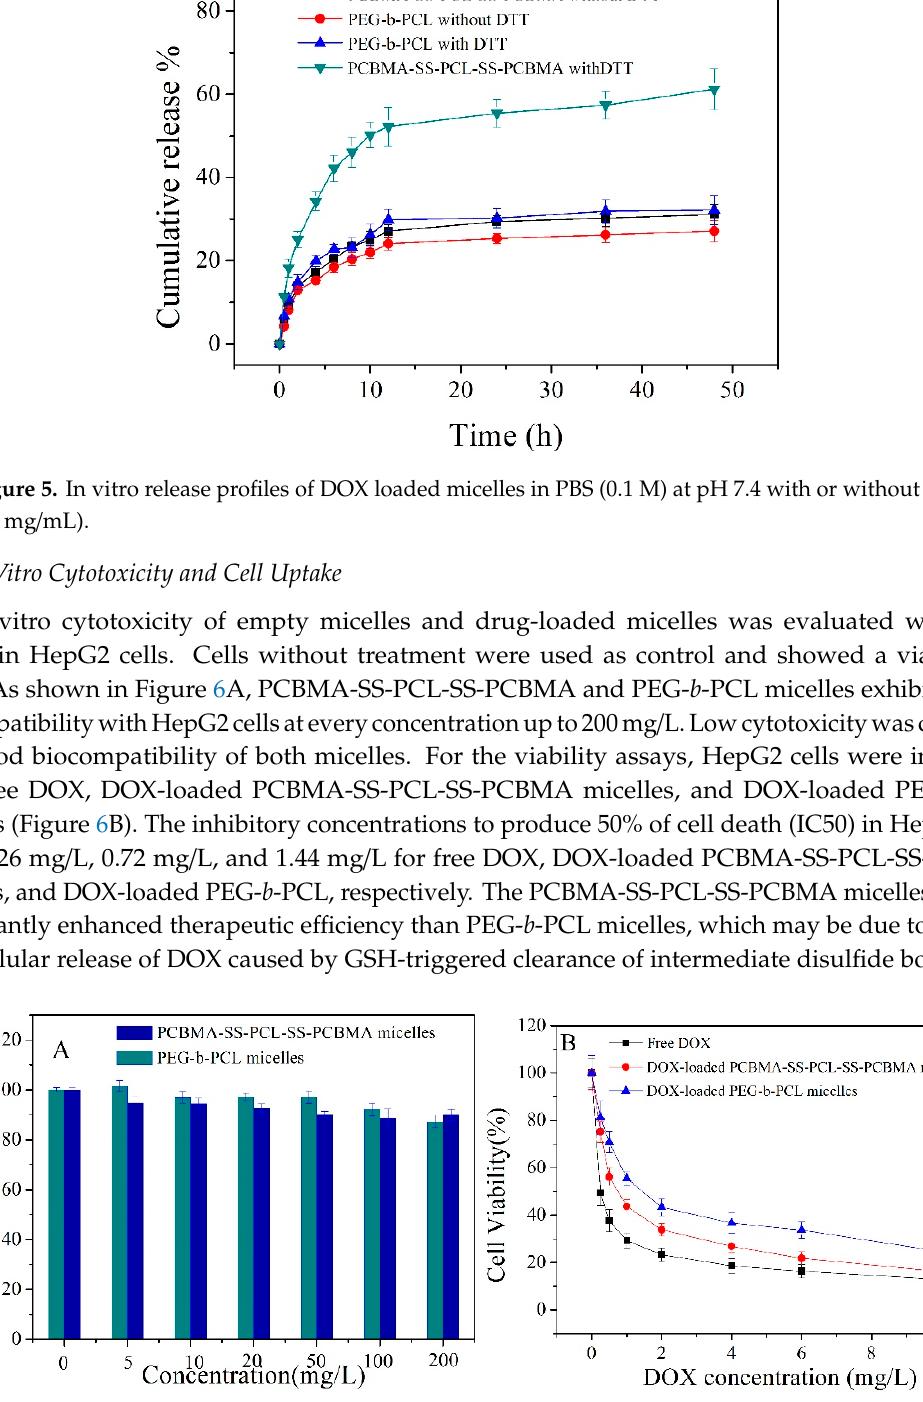
Figure 6. Toxicity of empty PCBMA-SS-PCL-SS-PCBMA and PEG- b -PCL micelles ( A ) and free DOX, DOX-loaded PCBMA-SS-PCL-SS-PCBMA and DOX-loaded PEG- b -PCL micelles in HepG2 incubated for 24 h ( B ). Data are presented as the average (standard deviation (n = 3).